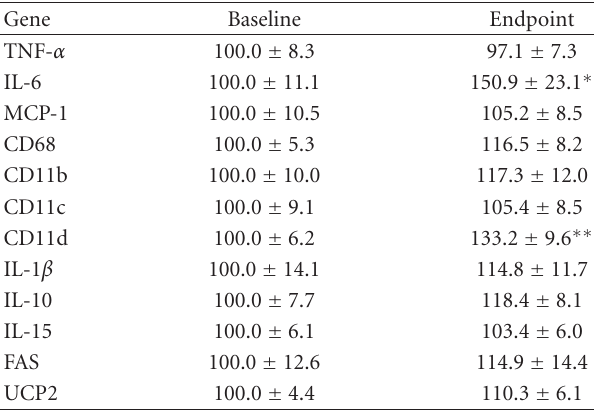
Table 4: Relative transcript abundances of inflammatory and metabolic markers in subcutaneous adipose tissue before and after diet intervention for all subjects.